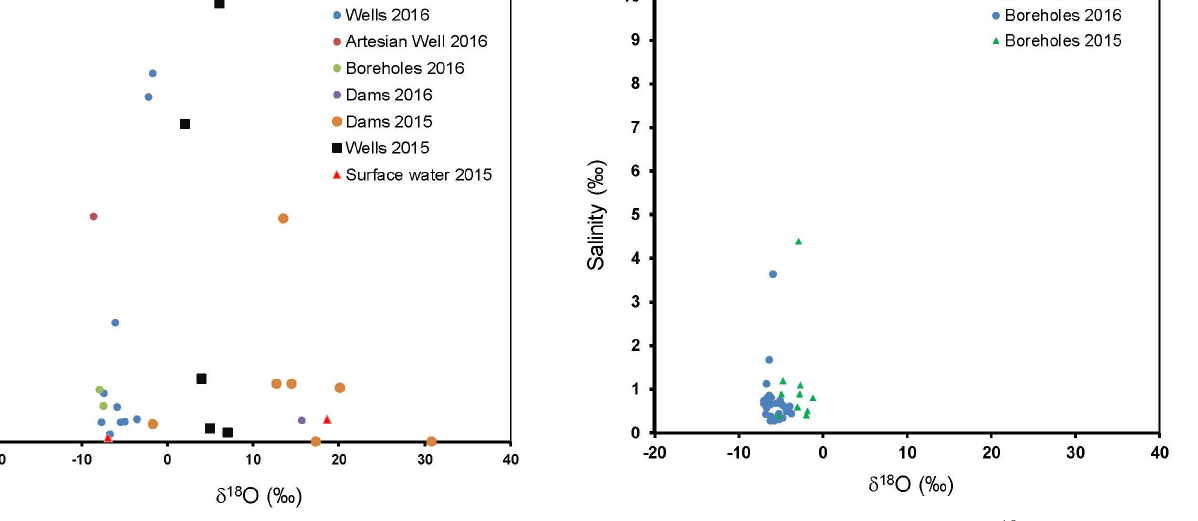
Figure 4. Plot of the stable oxygen isotopes ( δ 18 O) vs. salinity for water samples from the Cuvelai-Etosha Basin.